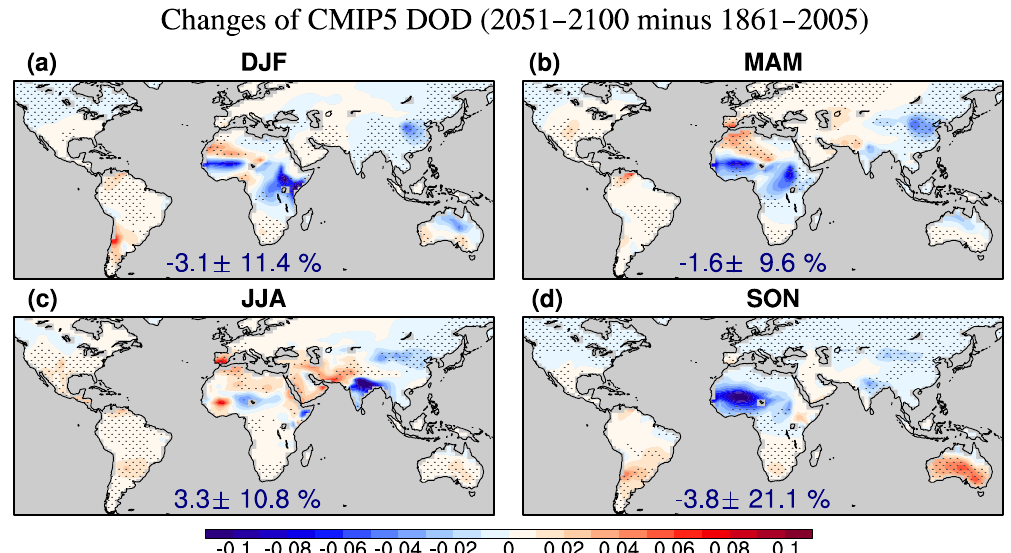
Figure 7. Projected changes of DOD in the late half of the 21st century (under the RCP8.5 scenario) from that in the historical level (1861– 2005) by the CMIP5 multi-model mean for four seasons. The percentage change of global mean (over land) DOD ± 1 inter-model standard deviation is shown at the bottom of each plot. Areas with sign agreement among the models reaching 71.4% (i.e., at least five out of seven models have the same sign as the multi-model mean) are